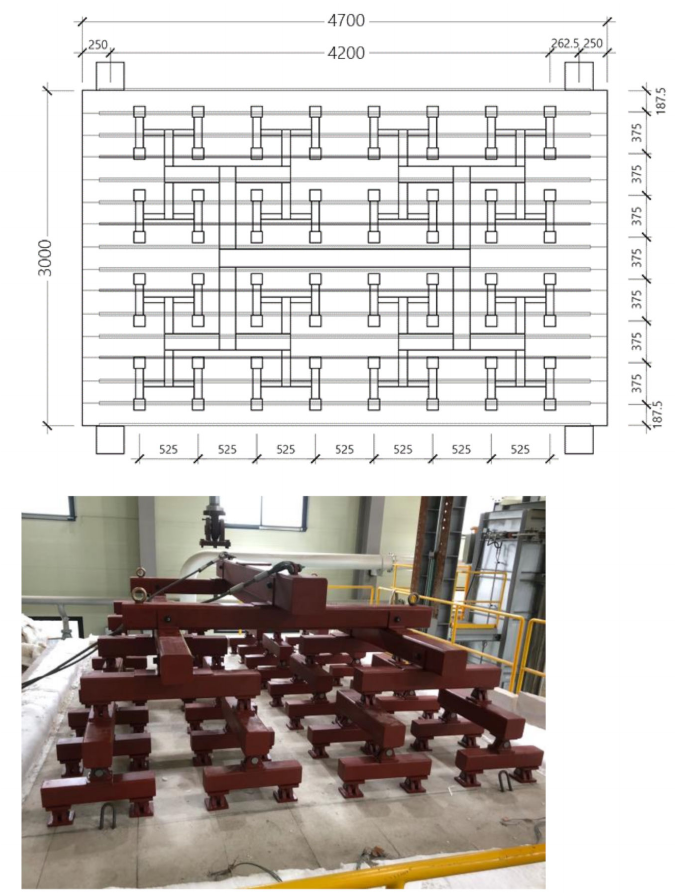
Figure 5. Fire-resistance test specimen loading and installation (unit: